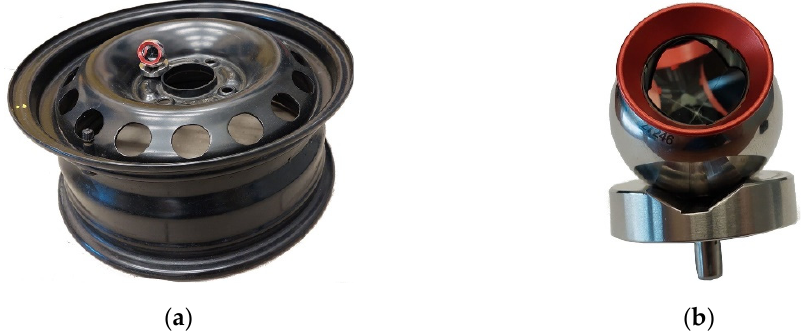
Figure 12. Elements used during tests: ( a ) detail; ( b ) retroreflector in a dedicated stand.